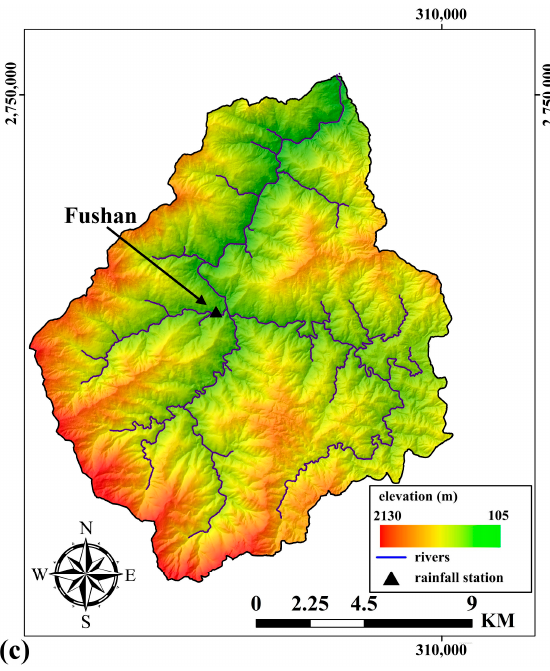
Figure 1. The distribution of elevation, river, and rainfall stations in the Laonong river water (LRW, ( a )), Nanou river watershed (NoRW, ( b )), and Nanshih river watershed (NsRW, ( c )).